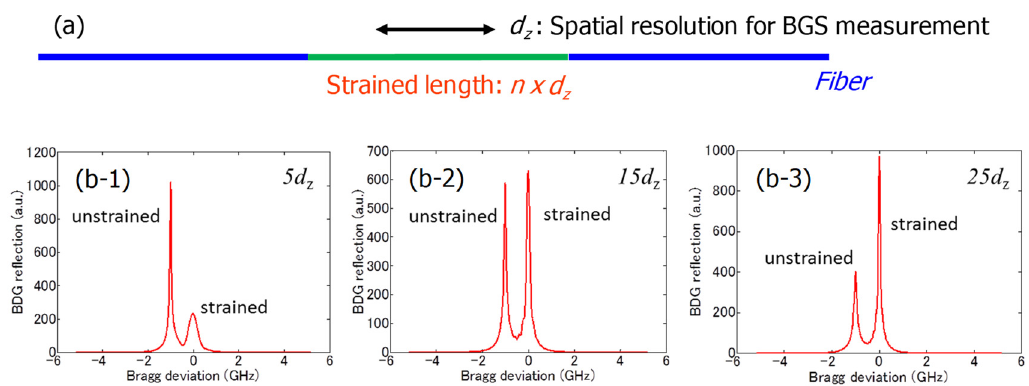
Figure 44. Simulation results of the BDG reflection spectrum shape. ( a ) Fiber considered in the simulations; strained section is set at the correlation peak position whose length is changed in the simulations. ( b ) BDG reflection spectra simulated for the cases with different lengths of the strained section; ( b-1 ), ( b-2 ), and ( b-3 ) correspond to the strained section lengths of 5 d z , 15 d z , and 25 d z , respectively, where d z is the theoretical spatial resolution for BOCDA [108].